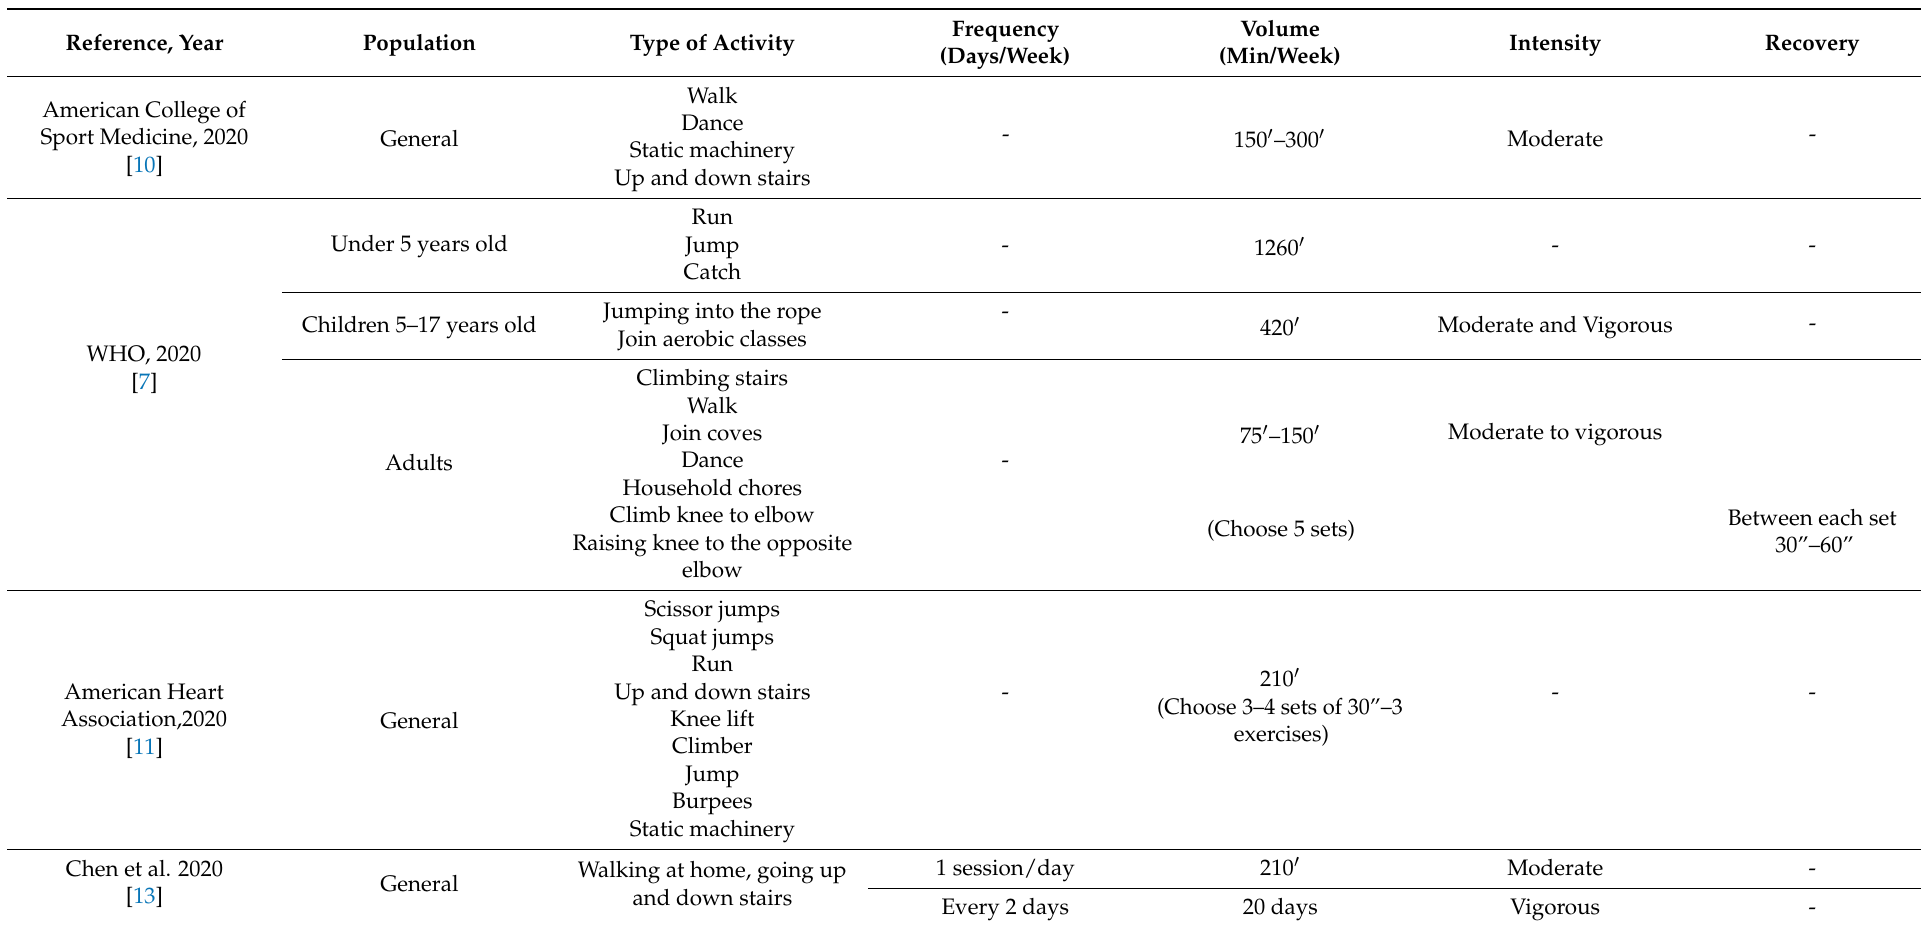
Table 1. Aerobic activity